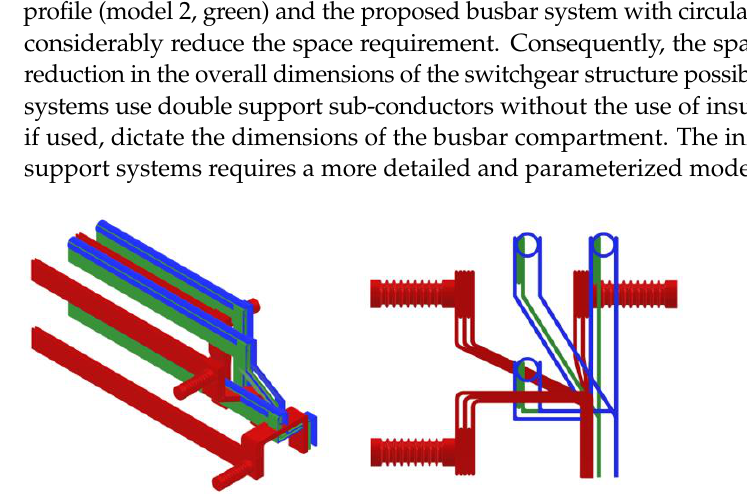
Figure 17. Comparison of the existing and proposed busbar systems.